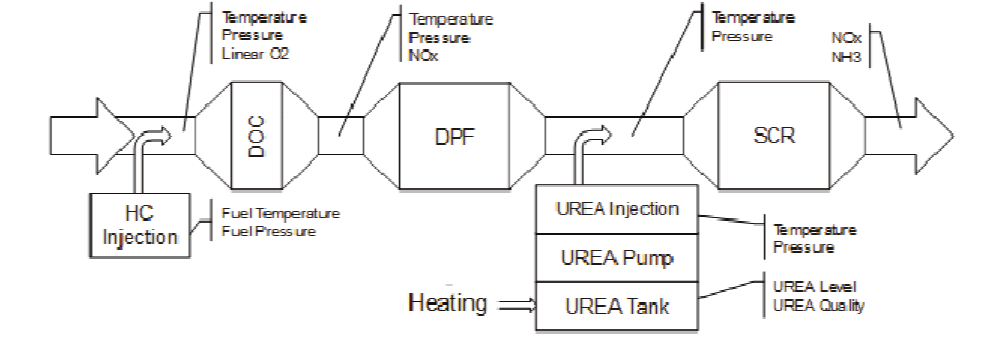
Fig. 1. Current diesel exhaust system example